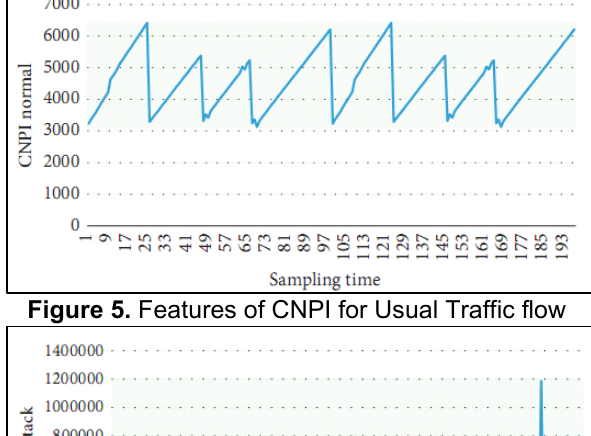
Figure 5. Features of CNPI for Usual Traffic flow